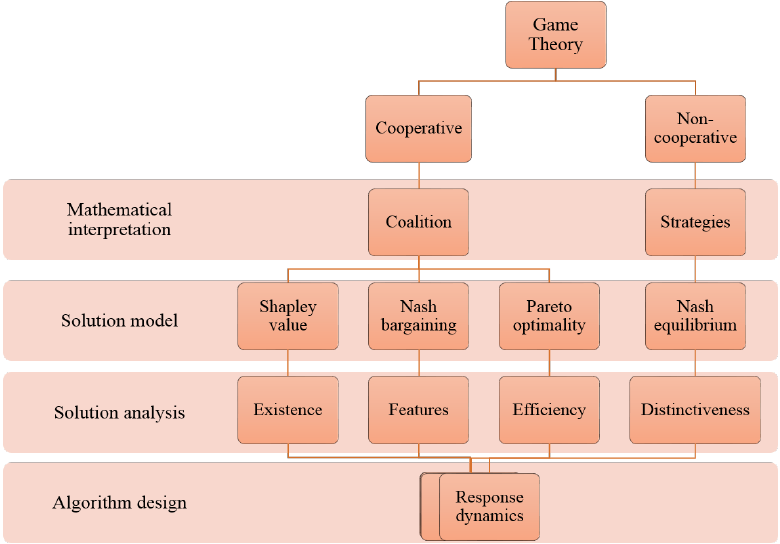
Figure 4. Taxonomy of game theory and solution concepts for the transaction-based energy (TE) model (adapted from